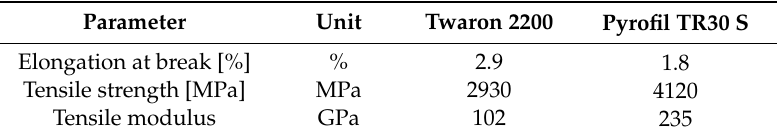
Table 1. Mechanical properties of used reinforcing fibers.